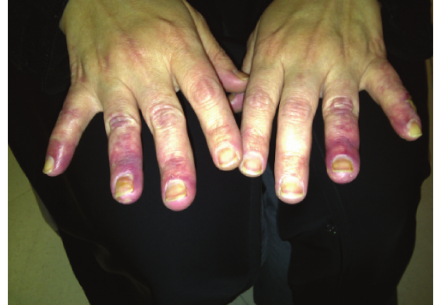
Figure 1: Prior to rituximab therapy.